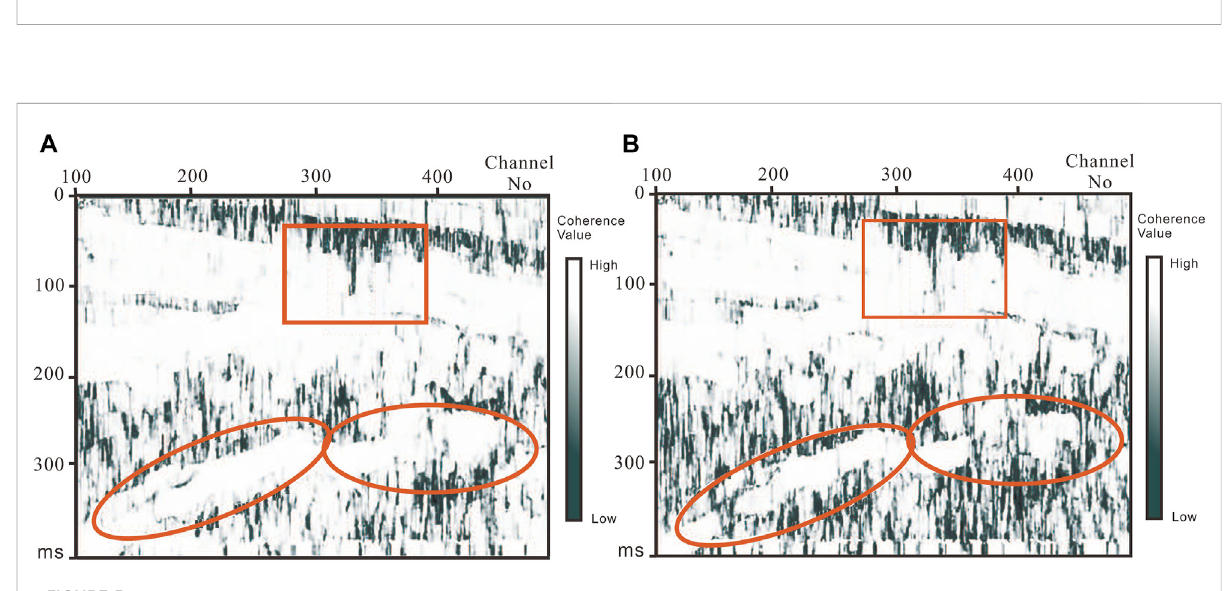
FIGURE 5 Slice of single frequency coherent attributes along layers (A) Results from conventional methods (B) Results obtained by this